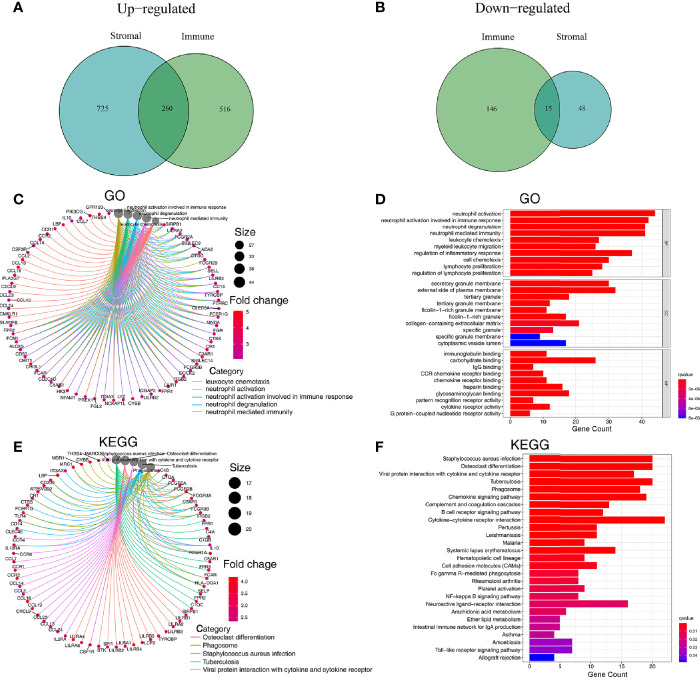
Analysis of genes affecting the TME and their associated GO and KEGG enrichment. (A, B) Venn plots showing 260 up-regulated DEGs and 15 down-regulated DEGs shared by ImmuneScore and StromalScore (thresholds for differential gene expression set at an FDR adjusted P-value <0.05 and log2FC>1). (C, D) GO enrichment analysis for 275 microenvironmentally relevant DEGs, the statistical threshold set at P-value < 0.05 with an FDR adjusted P-value < 0.05. (E, F) KEGG enrichment analysis for 275 microenvironmentally relevant DEGs, the statistical threshold set at P value < 0.05 with an FDR adjusted P-value < 0.05.